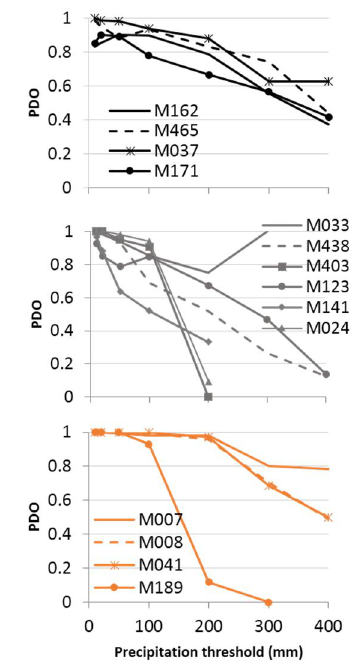
Figure 4. POD for precipitation thresholds of 10, 20, 50, 100, 200, 300 and 400 mm on the Coastal plains (black), Andean highlands (grey) and Amazonian rainforest (orange) ETS values were lower than those of POD as they have